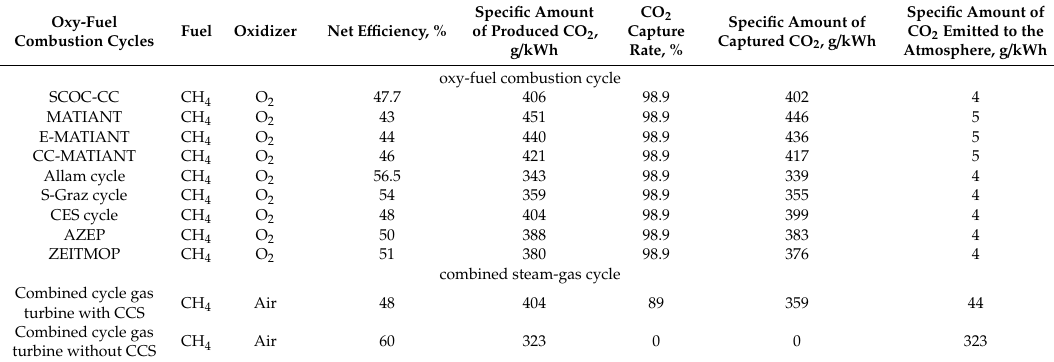
Table 1. Technical and economic characteristics of oxy-fuel combustion technologies and combined steam-gas